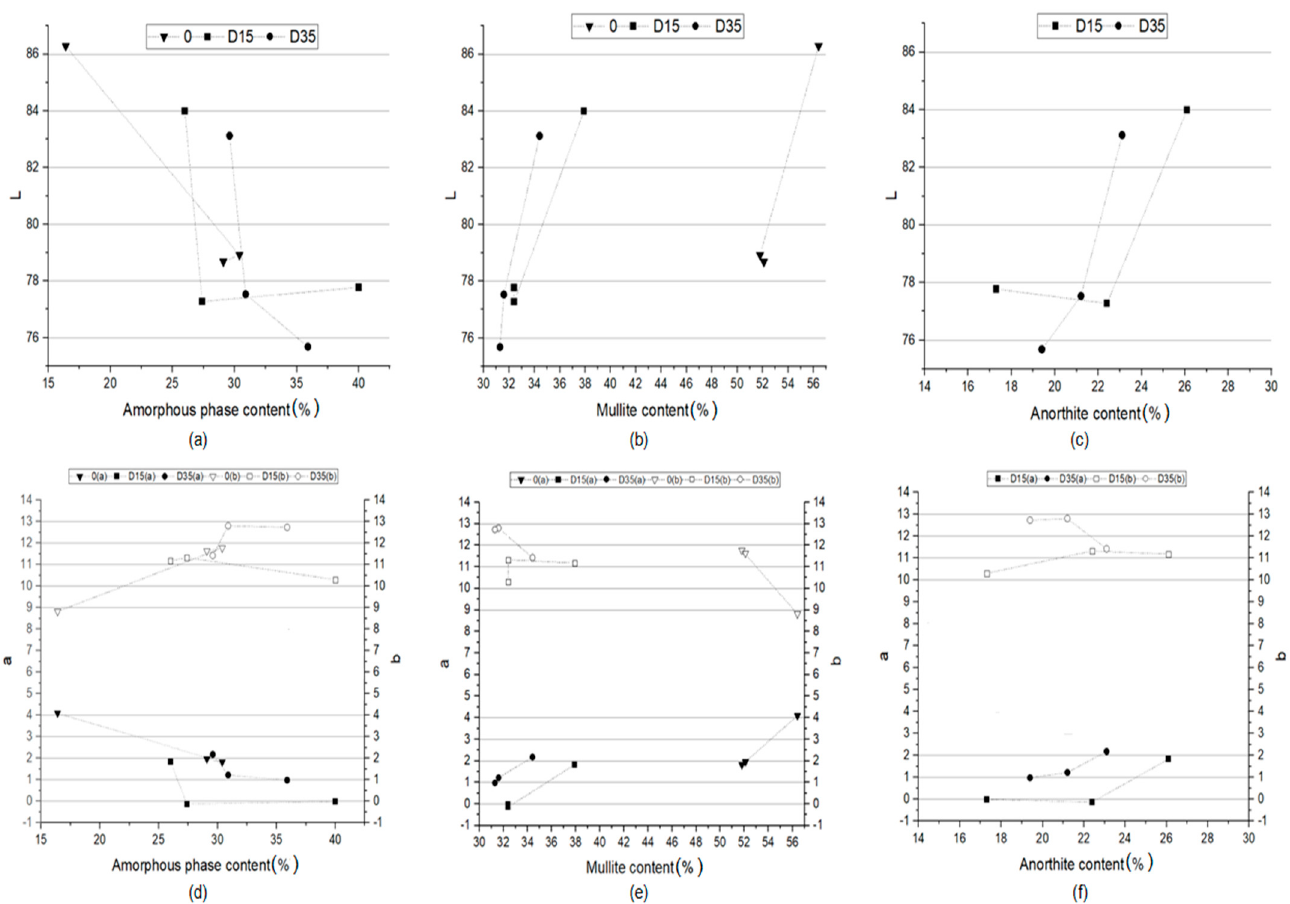
Figure 11. Dependence between a indicator and ( a ) amorphous phase content, ( b ) mullite content, ( c ) anorthite content and dependence between b indicator and ( d ) amorphous phase content, ( e ) mullite content, ( f ) anorthite content in the phase composition of obtained ceramic materials.